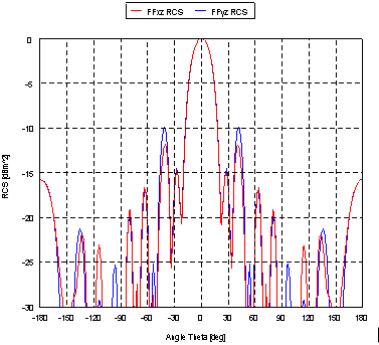
Fig.3. Radar cross-sections of single (a) and linear chain of 3 mesoscale cubes (b) in far